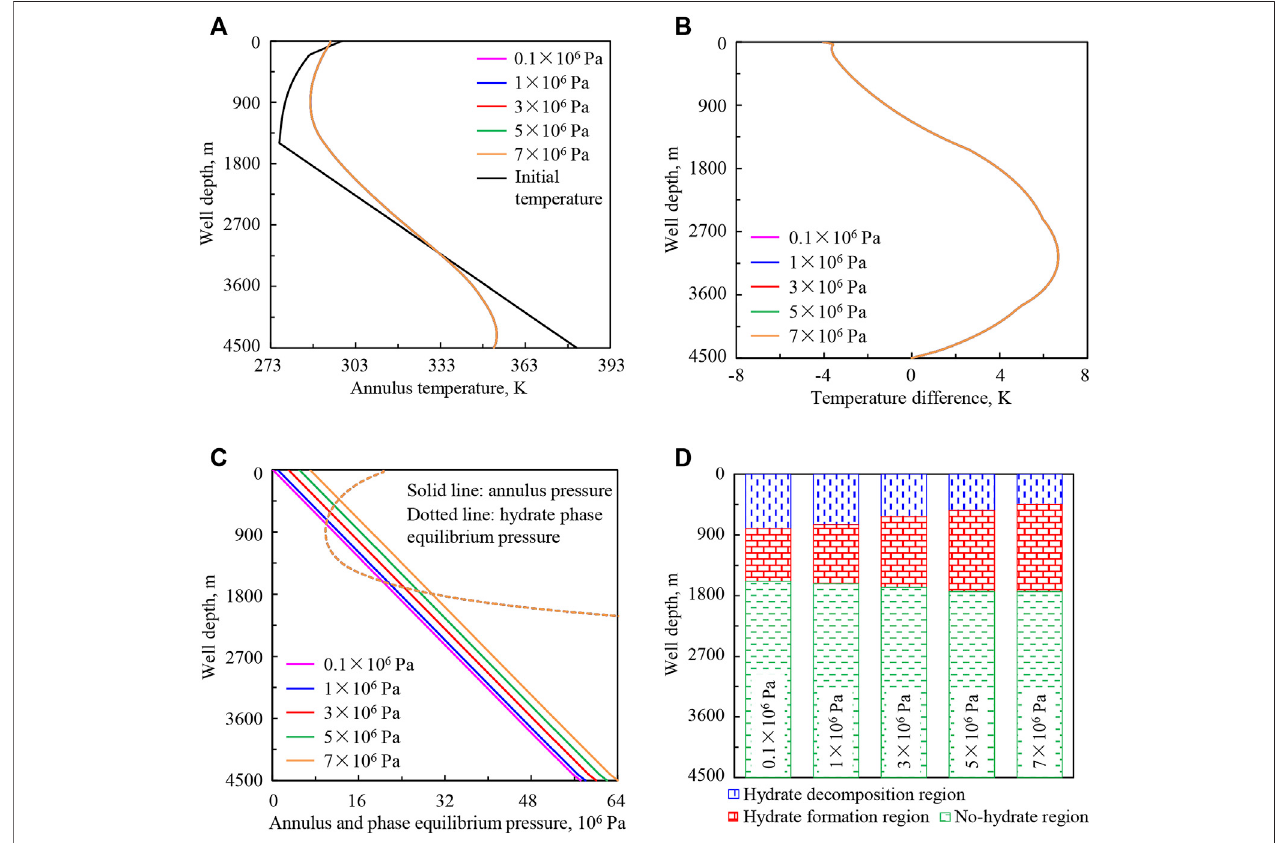
FIGURE 10 | Variation regularities of wellbore temperature fi eld, pressure fi eld, and hydrate formation region in deep-water drilling under different wellhead backpressures: (A) annulus temperature, (B) temperature difference between the drilling fl uid in the annulus and in the drill string, (C) annulus pressure and phase equilibrium pressure, (D) hydrate formation region. The lines under different wellhead backpressures in (A , B) are